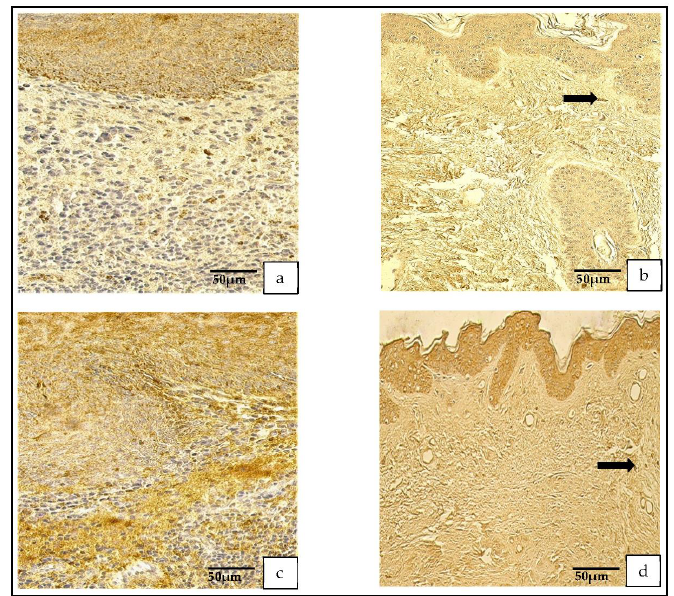
Figure 6. ( a – d ) Immunohistochemical micrographs. ( a ) Cholesteatoma . Numerous IL – 1-positive cells in the matrix and in the perimatrix, IL – 1 IHC. ( b ) Skin. Moderate-to-numerous IL – 1-positive cells in the epithelium and a few in the connective tissue (arrow), IL – 1 IHC. ( c ) Cholesteatoma Numerous IL – 10-positive cells in the matrix and moderate in the perimatrix, IL – 10 IHC. ( d ) Skin. Numerous IL – 10-positive cells in the epithelium and a few in the connective tissue (arrow), IL – 10 IHC. The distribution of the tissue-defensin- HβD -2-containing cells was graded from none (0) to moderate-to-numerous (++/+++) and the HβD -4-positive cells displayed a variance from no (0) to numerous (+++) positive cells. However, in the control group, the number of HβD -2- and HβD -4-positive cells ranged from none (0) to moderate (++) (Figure 7a – d).